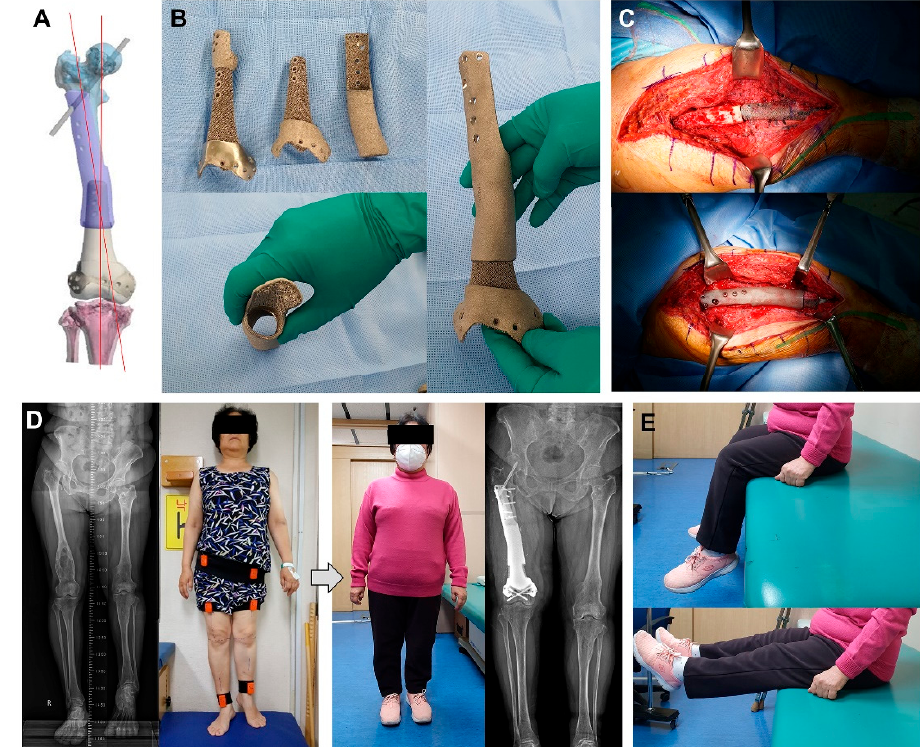
Figure 4. Revision limb salvage surgery using 3D-printed connector in the femur. ( A ) A graphic design of the 3D-printed connector. ( B ) Photographs of the previous 3D-printed implant (duplicated), broken implant (duplicated), and the 3D-printed connector. ( C ) Intraoperative photographs before and after application of the 3D-printed connector. ( D ) Preoperative teleradiograph and photograph showing the chondrosarcoma of the right distal femur and limb length discrepancy of 10 cm ( left ), and final postoperative pictures ( right ). ( E ) Photographs showing normal knee joint function.